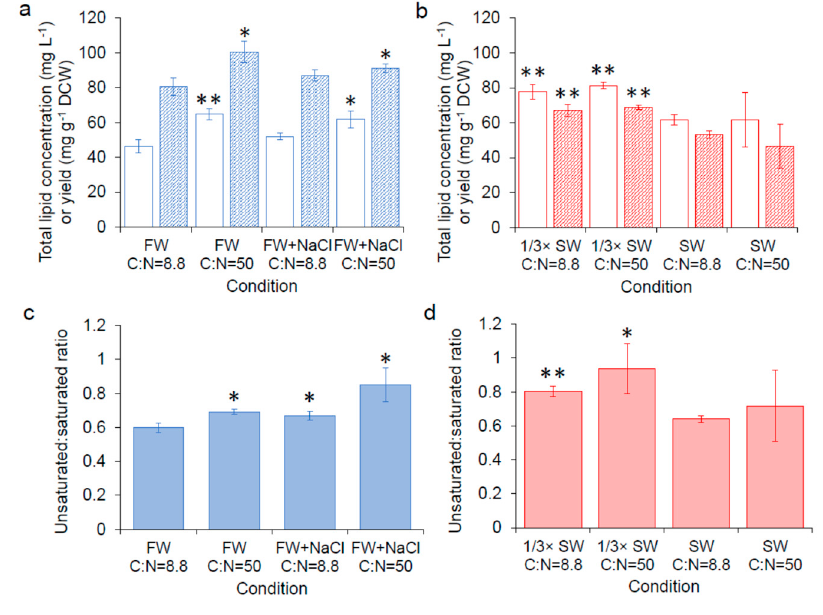
Figure 4. Lipid content. ( a ) Total lipid concentration ( ) and yield ( ) of SM14 in freshwater, ( b ) total lipid concentration ( ) and yield ( ) of SM14 in seawater, ( c ) the ratio of unsaturated fatty acids to saturated fatty acids in freshwater, ( d ) the ratio of unsaturated fatty acids to saturated fatty acids in seawater. FW: fresh water; FW + NaCl: fresh water with 0.05 M NaCl; SW: seawater. Error bars are standard deviations. *: Statistically significantly different from C:N = 8.8 in freshwater ( a , c ) or seawater ( b , d ) (* p -value < 0.05, ** p -value < 0.01).